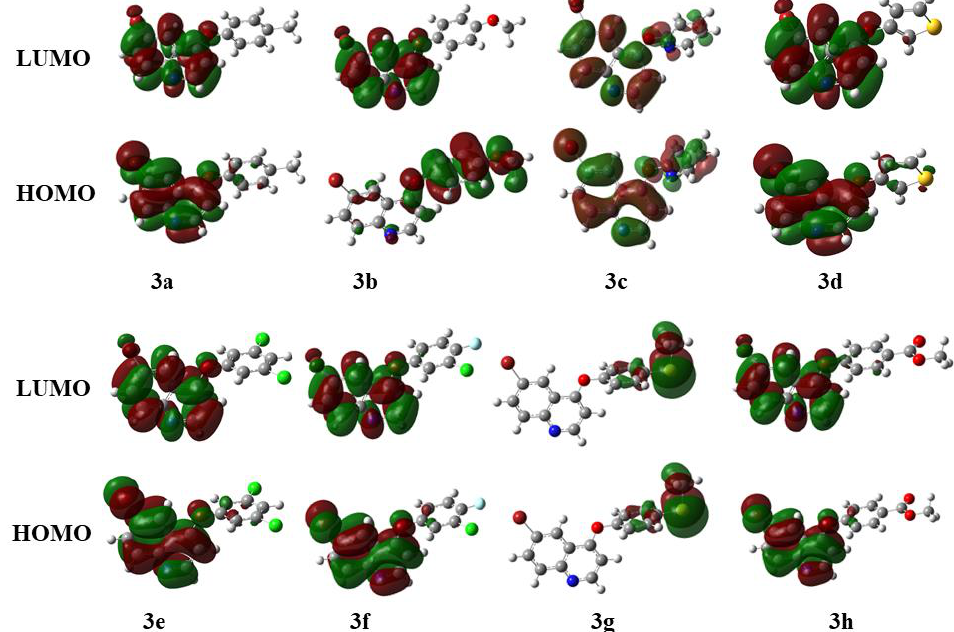
Figure 7. Optimized structures of derivatives ( 3a – 3h ) at the PBE0-D3BJ/def2-TZVP/SMD water level of theory.